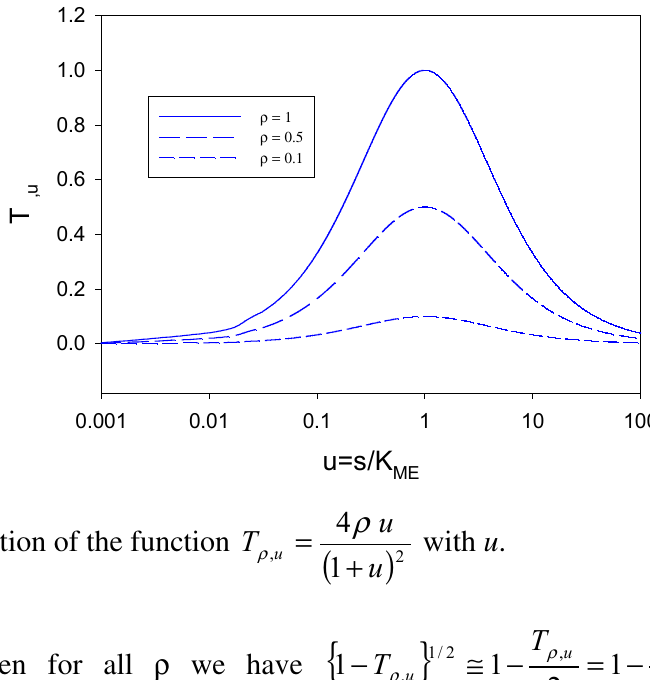
Figure 10. Variation of the function